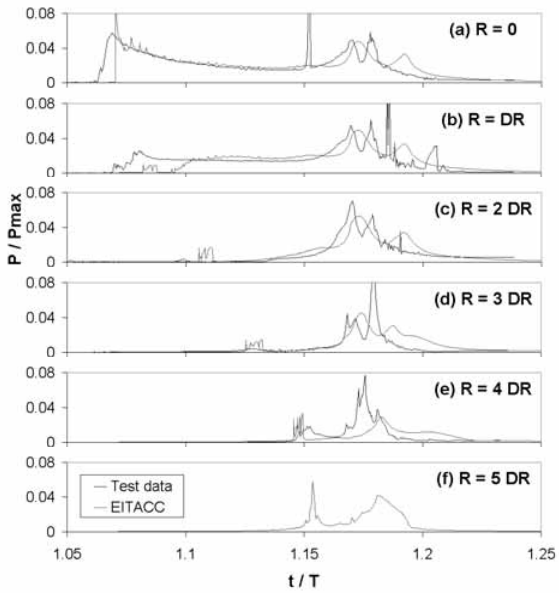
Fig. 5. Comparison of the EITACC predicted pressure loading (red curves) with data (blue